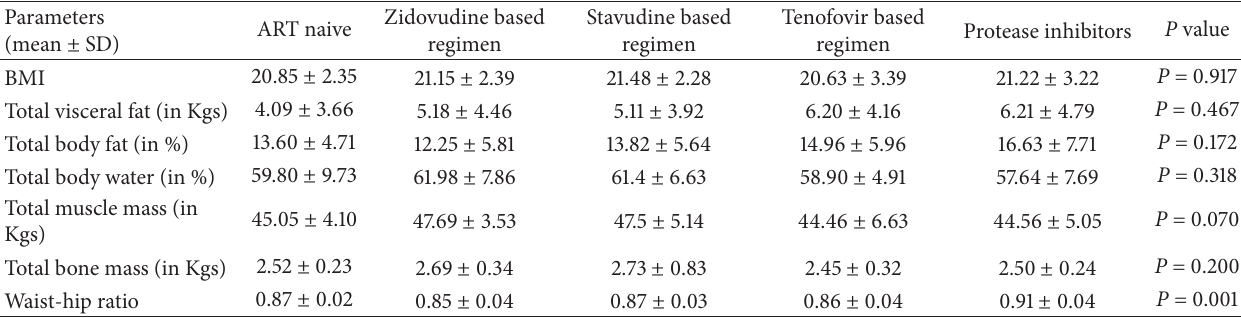
Table 4: Body composition parameters in study